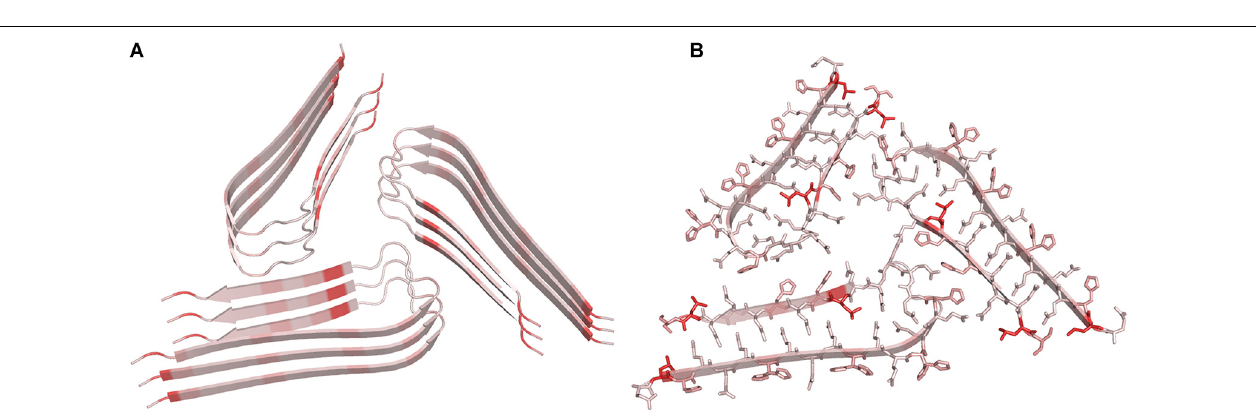
FIGURE 4 | Ribbon (A) and ball and stick representation (B) of the doublet Tau Fibril from corticobasal degeneration human brain tissue, the largest cross- β structure currently deposited in the PDB (code 6vh7). Residues are colored as function of their hydrophobicity from gray (polar) to red (apolar). In panel B, posttranslational modification sites are denoted with balls.